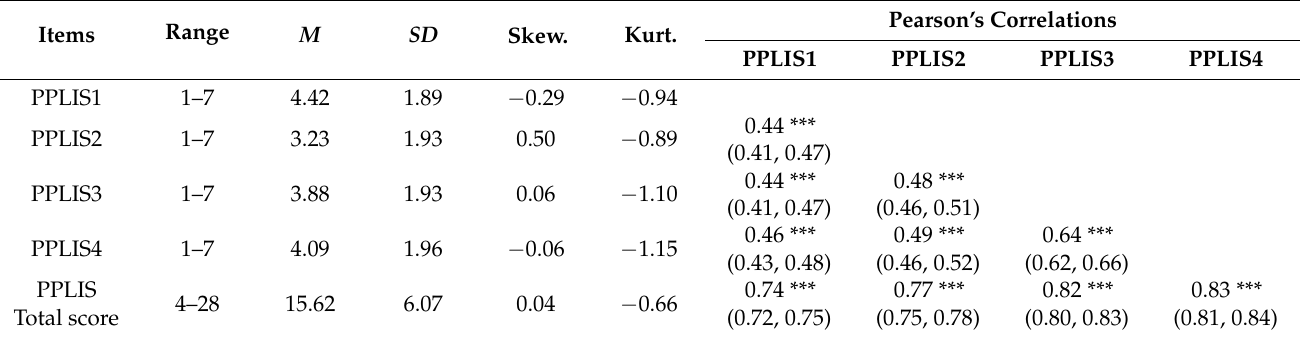
Table 1. Descriptive statistics for perceived positive lockdown consequences scale (PPLIS) in Sample 1 ( N =